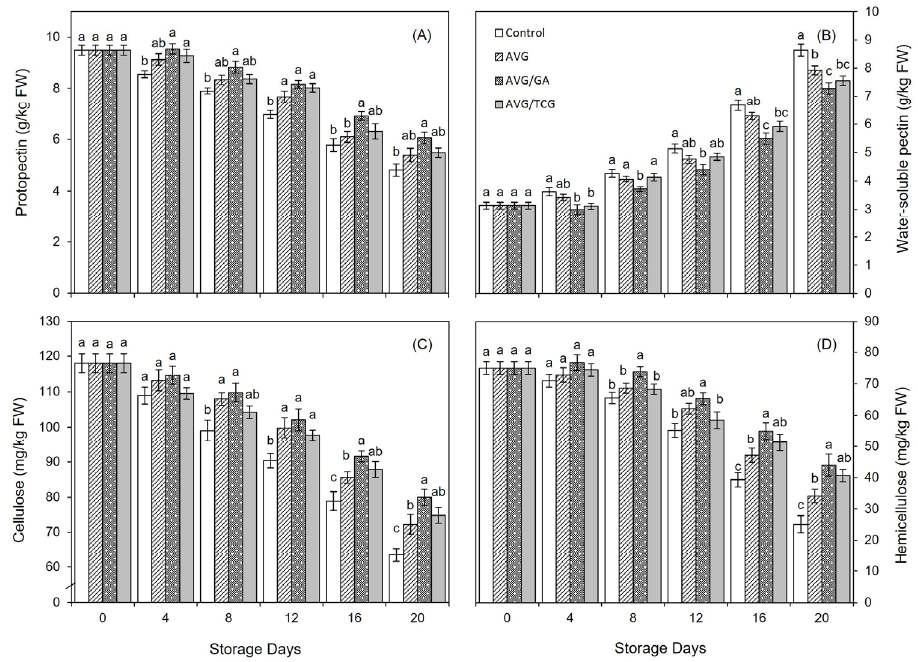
Figure 6. Effect of AVG-based composite coatings on protopectin content ( A ), water-soluble pectin content ( B ), cellulose content ( C ) and hemicellulose content ( D ) of persimmon fruits during 20 days storage (analysis on day 0, 4, 8, 12, 16 and 20) at 20 ± 1 °C and 80–85% relative humidity. All standard error bars are centered on means (3 biological replicates). Graph bars sharing same letters on a storage interval have non ‐ significance difference according to the LSD test at p ≤ 0.05.